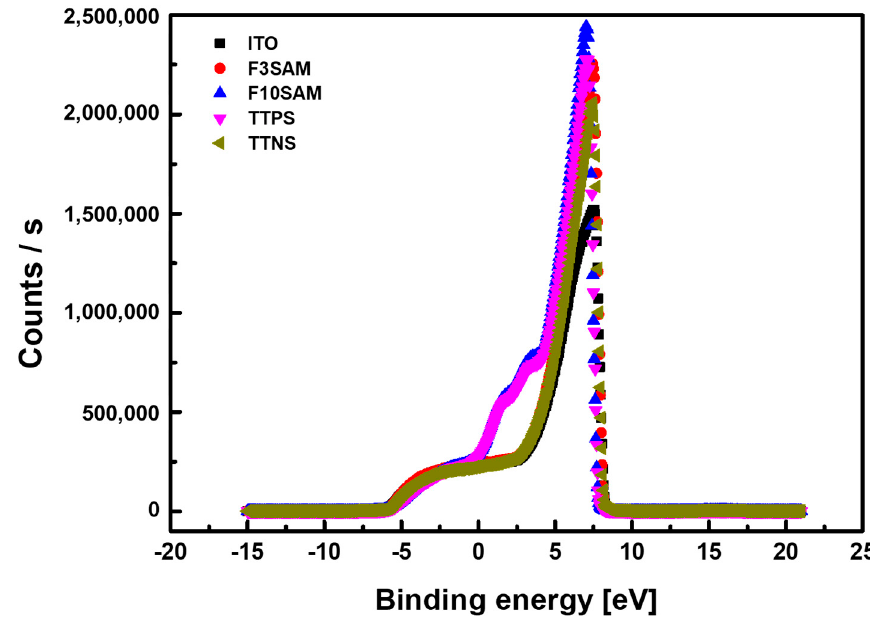
Table 1. Results of AFM measurements.